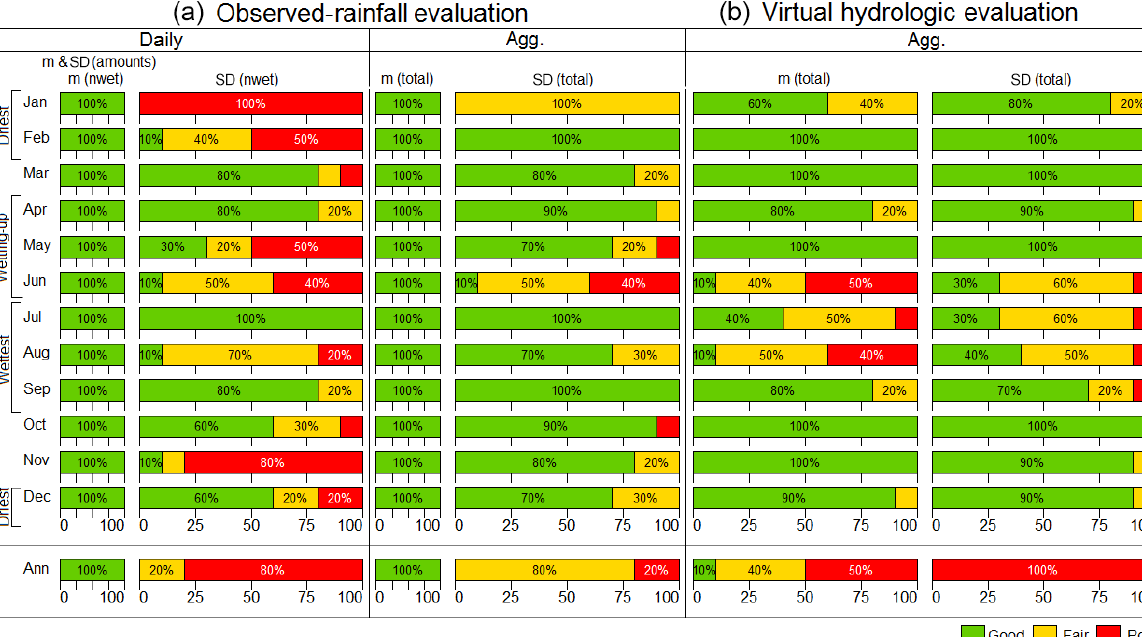
Figure 7. Integrated test, comparing observed-rainfall evaluation (a) with the virtual hydrologic evaluation (b) . Comparison of daily and aggregate (“Agg.”) rainfall statistics against aggregate flow statistics for individual months and years, where means are denoted as “m” and standard deviations as